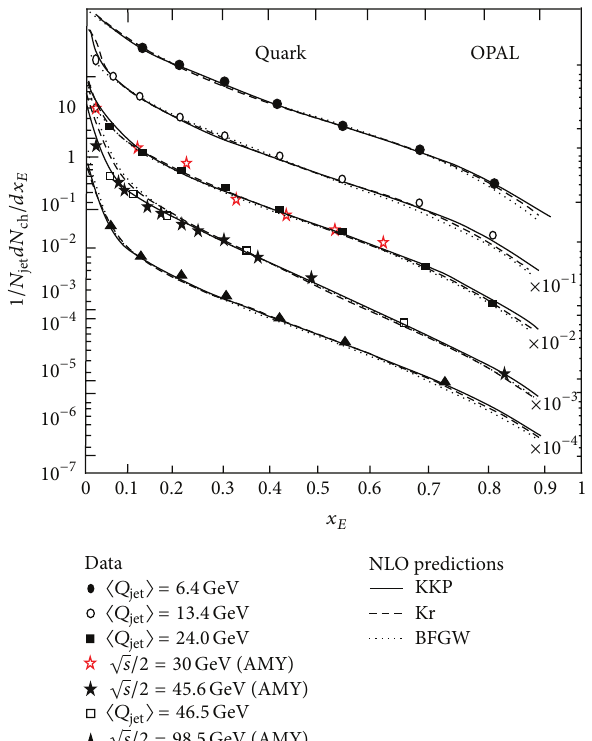
Figure 12: Dependency of the fragmentation functions of quark jets to 𝑥 𝐸 in different scales at different c.m. energies [12–15].